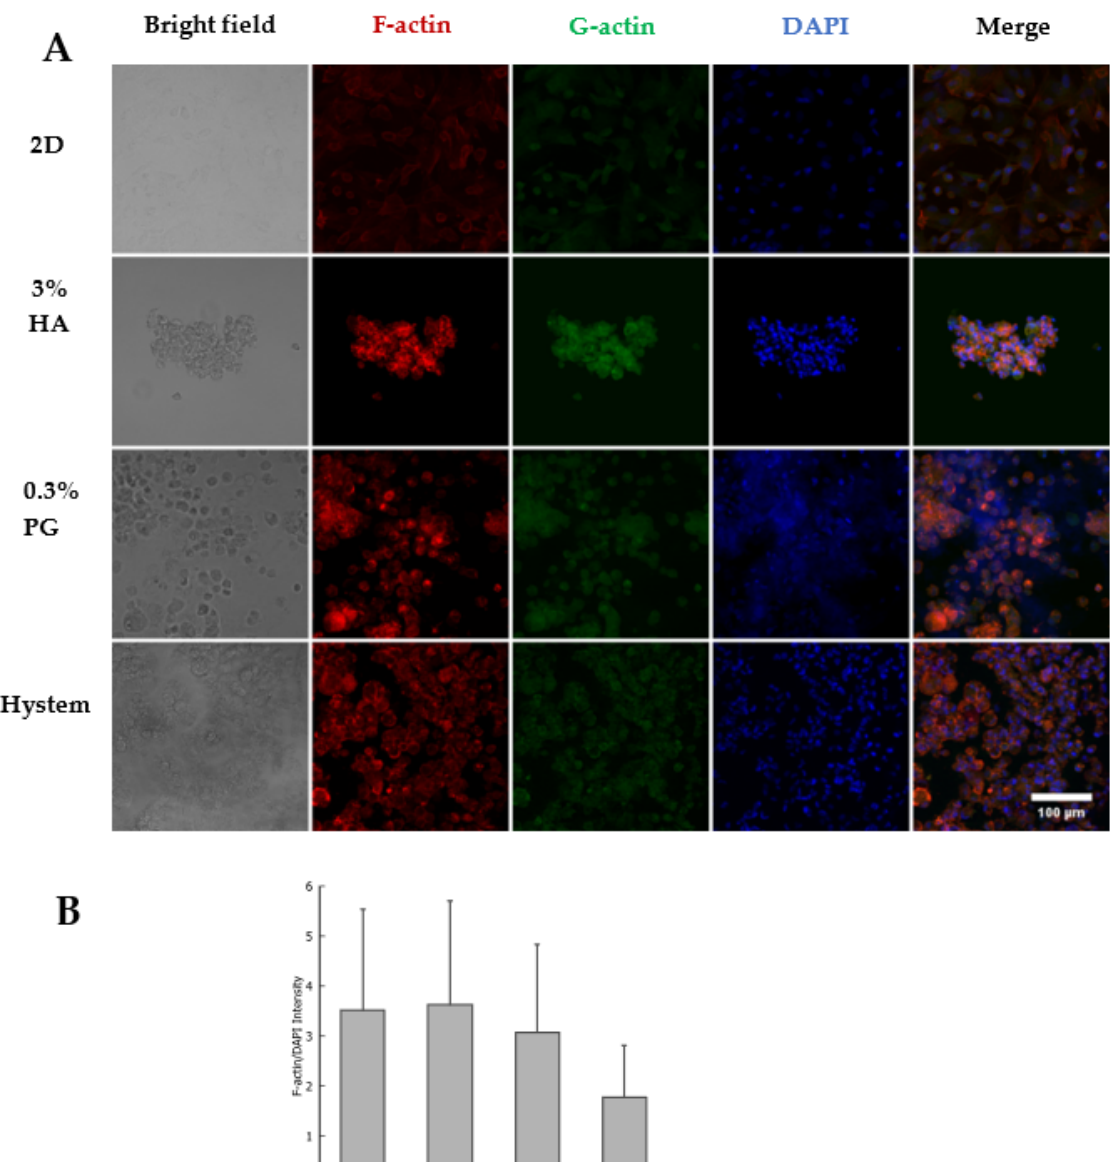
Figure 3. ( A ). Immunostaining of F- and G-actin in hADMSCs encapsulated in different materials and incubated at 37 °C overnight. Nucleus was labeled with DAPI. Scale bar = 100µm. ( B ). F-actin signal intensity shown as F-actin/DAPI. Results are shown as mean ± SEM.